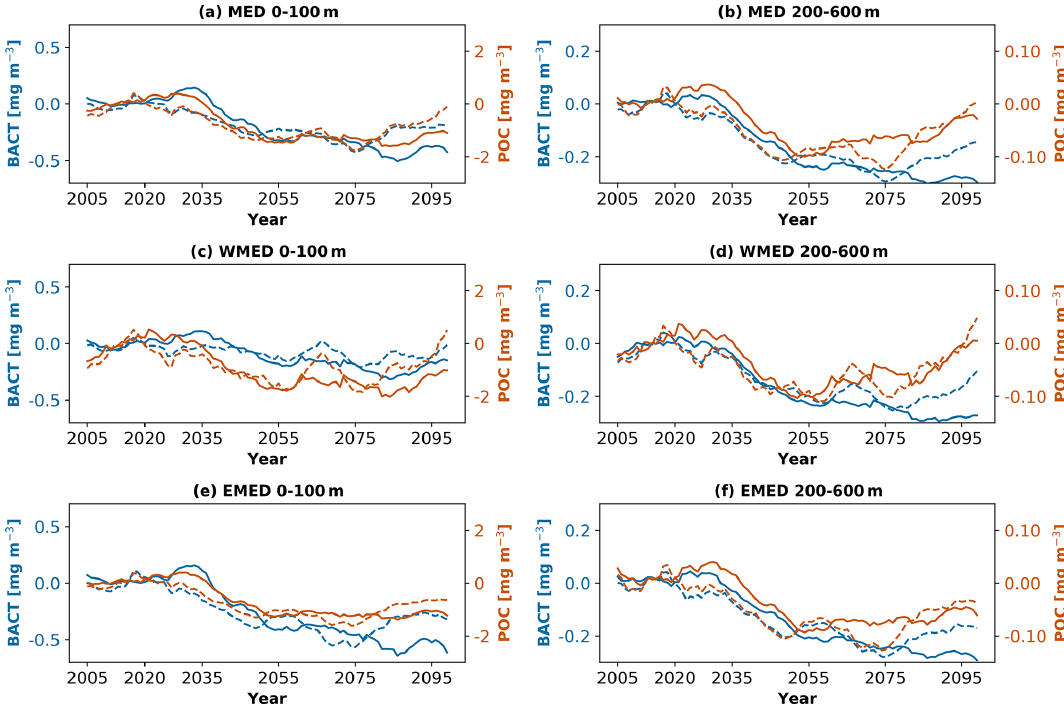
Figure 14. As Fig. 8, but for bacterial carbon biomass (blue, in mgm − 3 ) and particulate organic matter (dark orange, in mgm − 3 ).